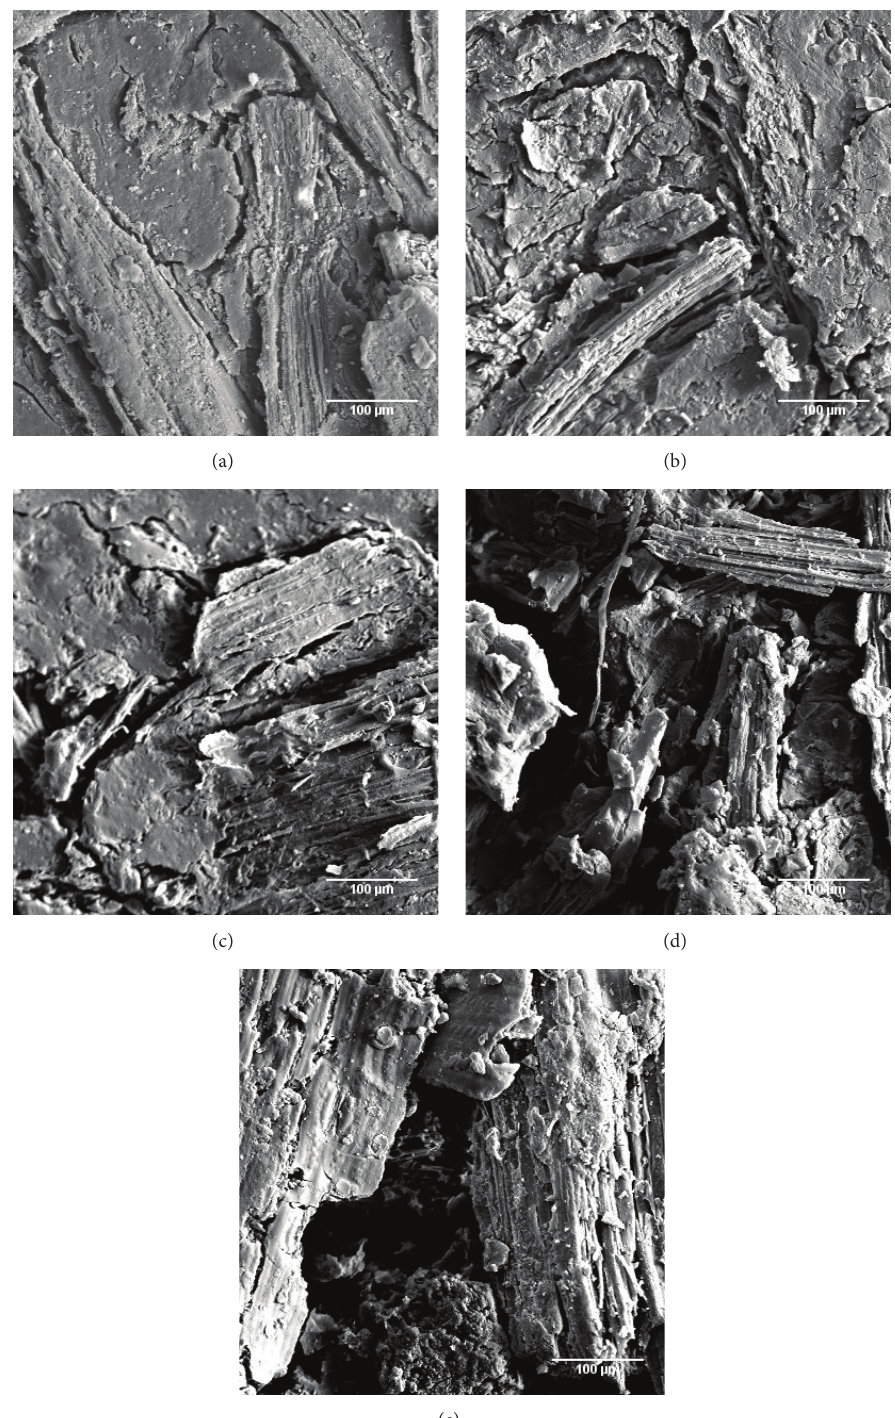
Figure 5: SEM image samples of the composites in 5 different aging periods: (a) in 20th aging period; (b) in 40th aging period; (c) in 60th aging period; (d) in 80th aging period; and (e) in 100th aging